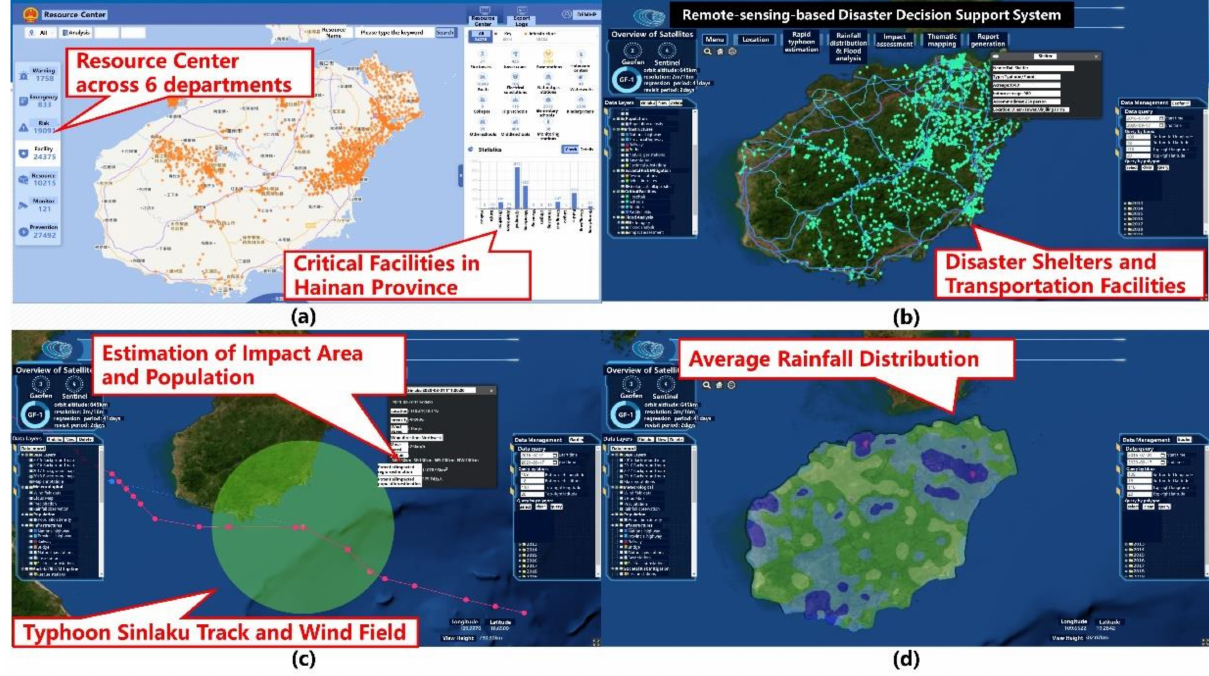
Figure 5. System application on Typhoon “Sinlaku”. ( a ) Resource center of RDDSS; ( b ) Foundation data layer of disaster shelters and transportation facilities; ( c ) Typhoon track, wind field, impact area, and population; ( d ) Rainfall intensity